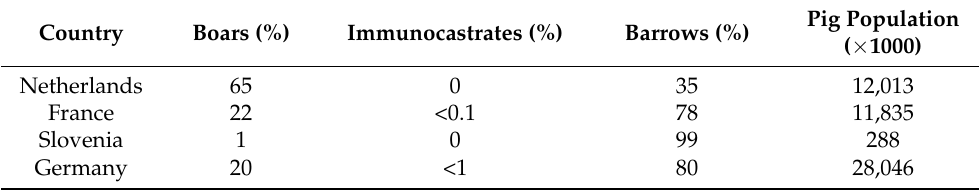
Table 3. Population shares of male pigs raised as boars, immunocastrates, or barrows in Europe in 2017 [28,32], ranked according to size of pig